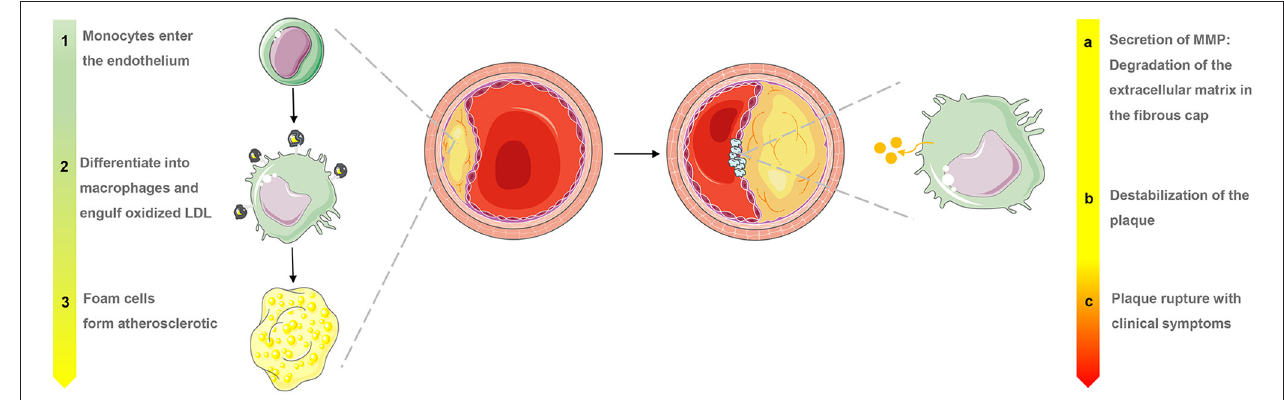
FIGURE 1 | Macrophage evolution in progressive stages and the role of matrix metalloproteinases (MMP) in the late stages of